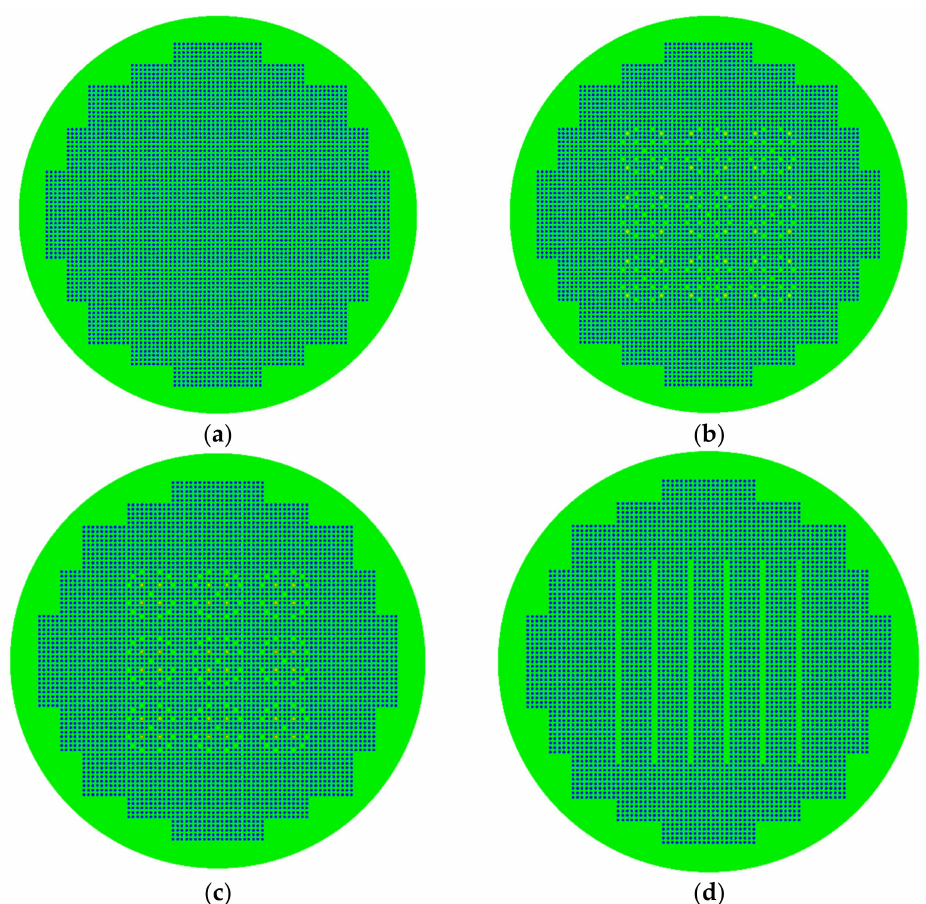
Figure 2. Layout of Critical Experiments in LCT-008 Benchmark Set. ( a ) LCT-008-001; ( b )